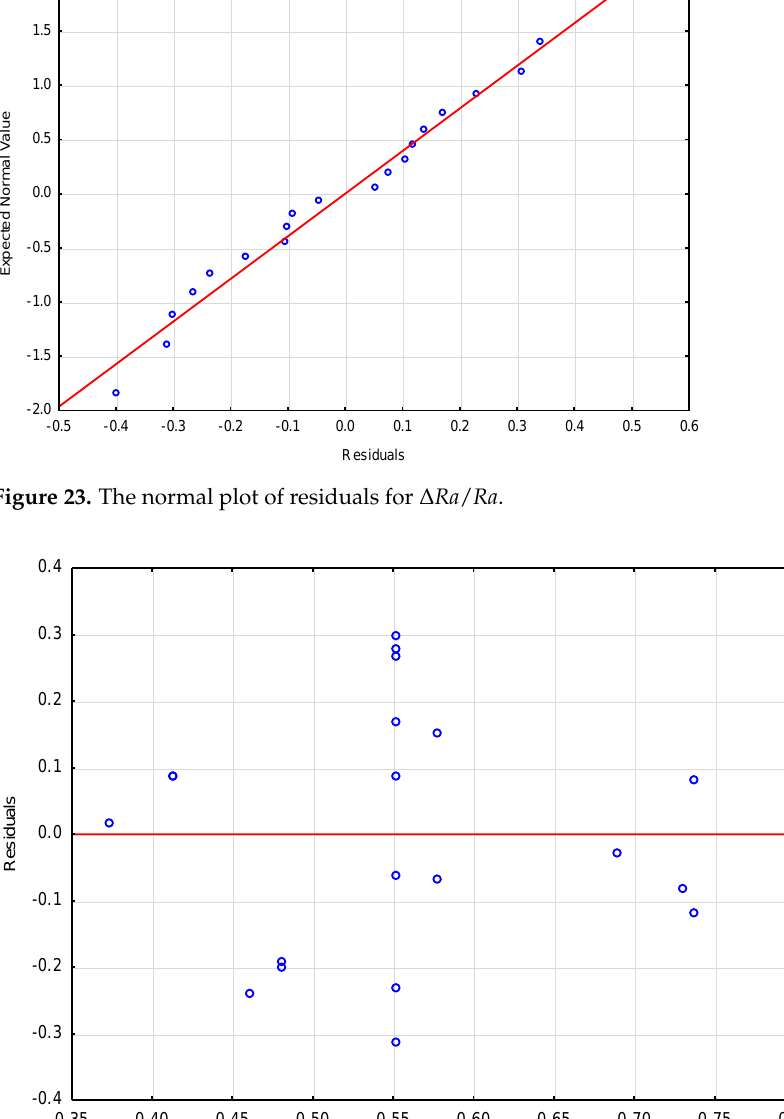
Figure 24. The residuals versus the predicted values for Δ Ra / Ra .